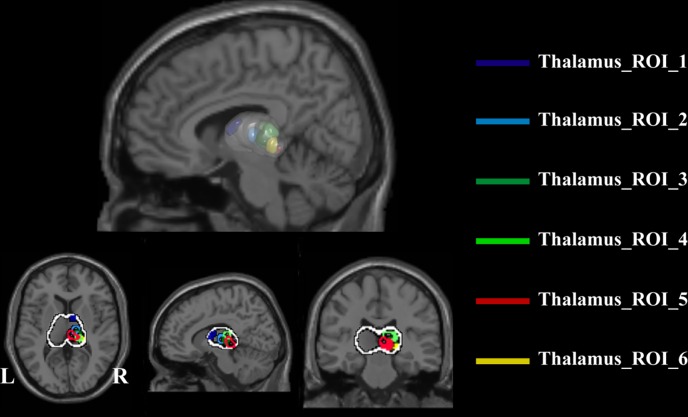
Location of thalamus subregion ROIs